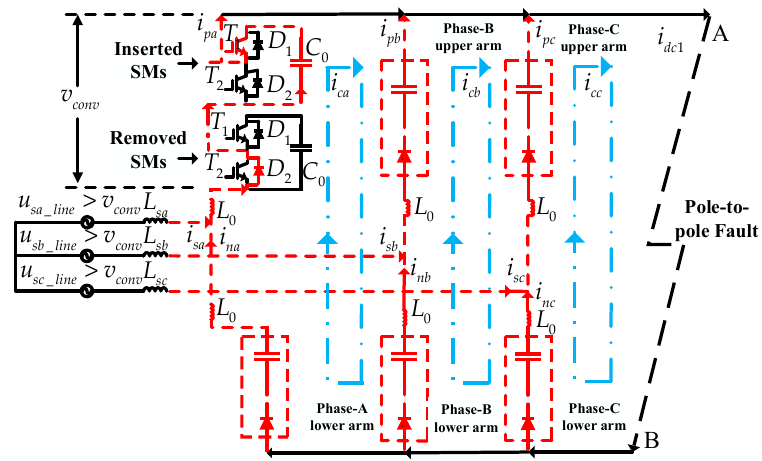
Figure 3. Direct current pole-to-pole fault circuit diagram before blocking submodules.